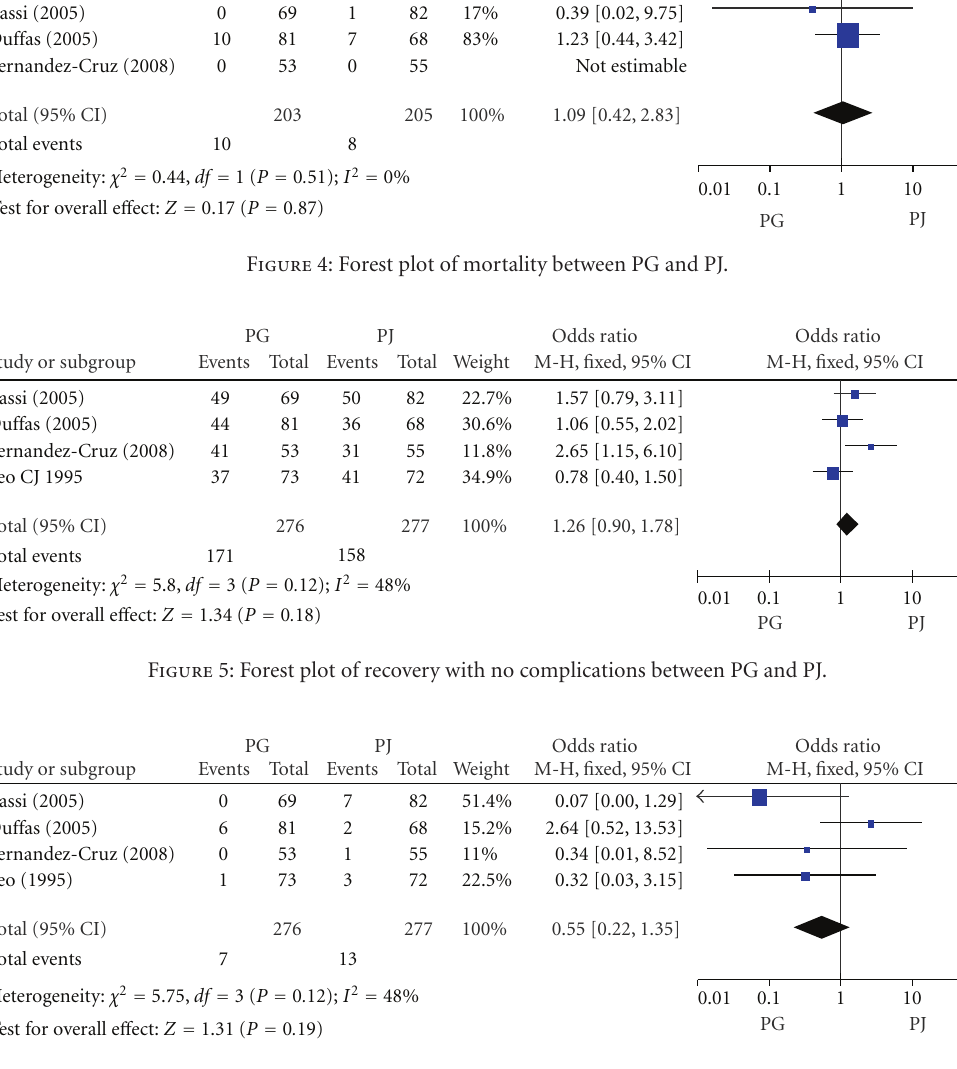
Figure 6: Forest plot of biliary fistula between PG and